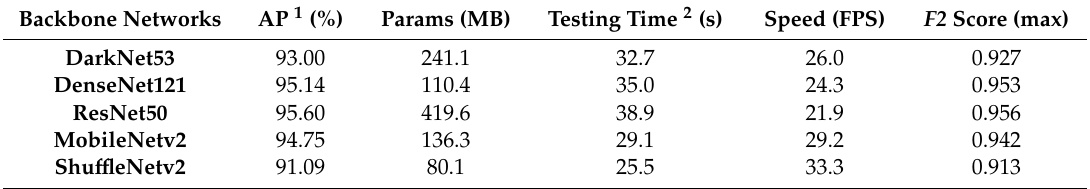
Table 6. Model comparison between the YOLOv3 model based on various backbone networks.